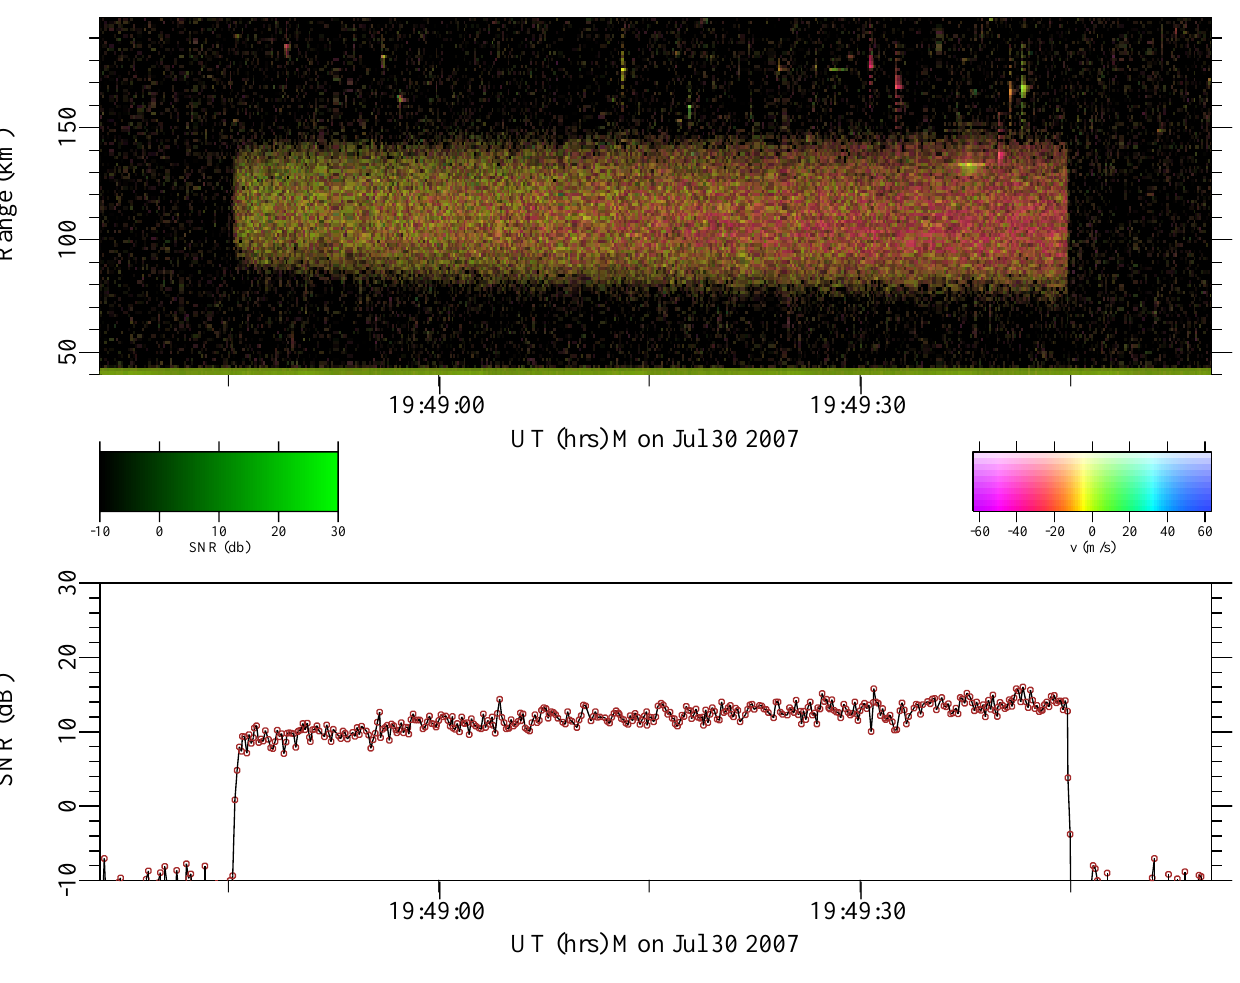
Fig. 4. Close-up view of one of the backscatter bands from the previous figure. The signal-to-noise ratio for apparent ranges between 90–130 km is plotted beneath the RTDI plot.